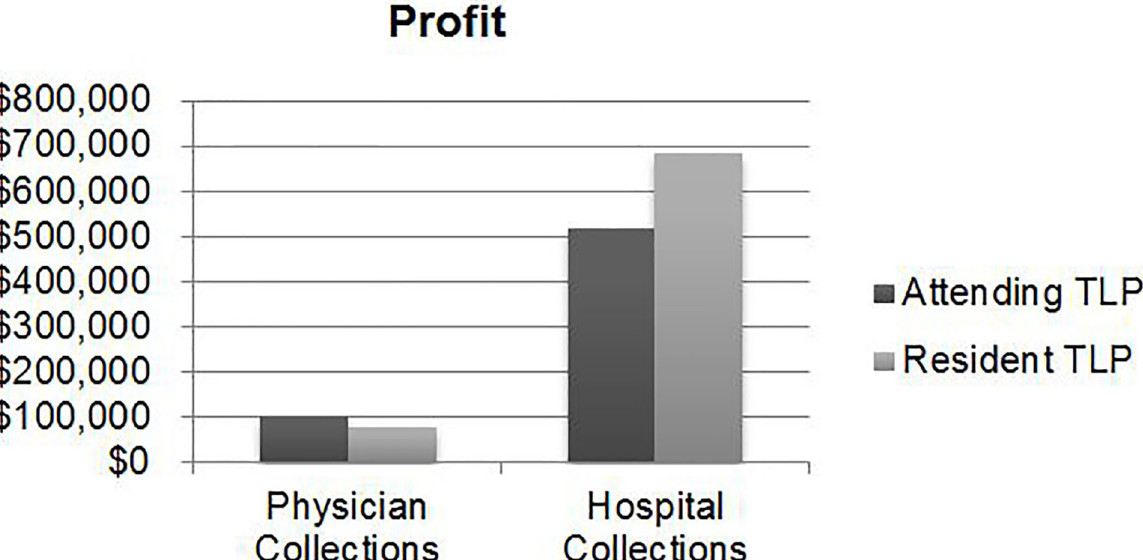
Figure 1. Difference in annual profit generated by attending triage liaison provider (TLP) and resident TLP, through physician collections and hospital